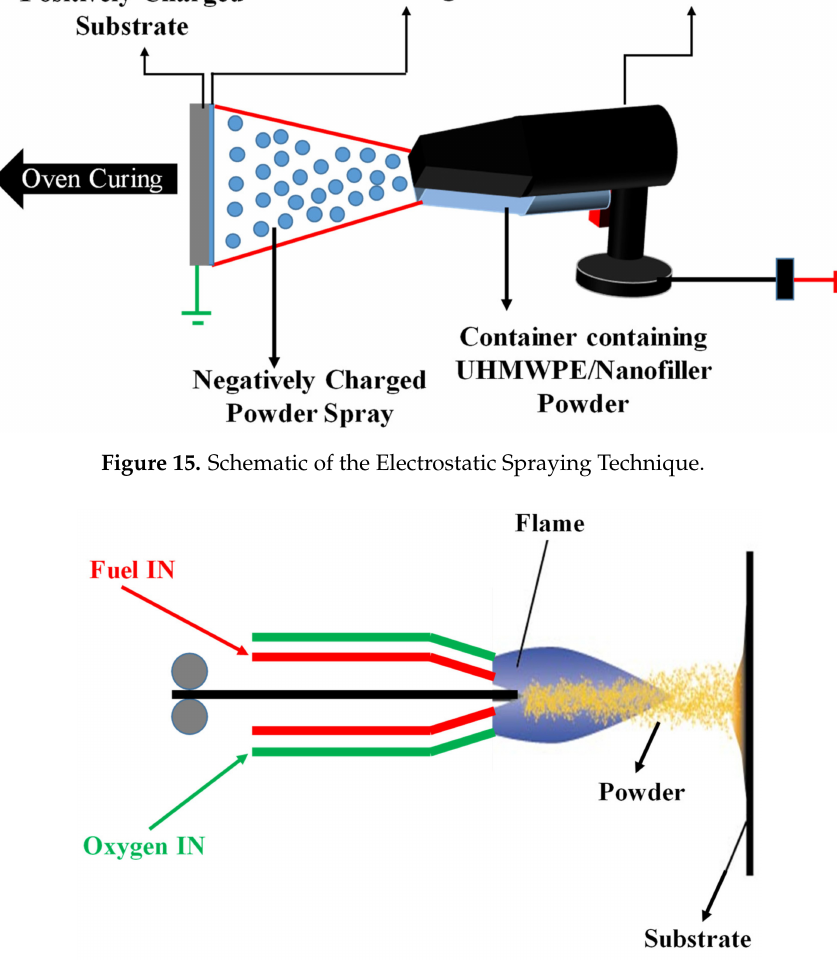
Figure 16. Schematic of the Flame Spraying Technique.